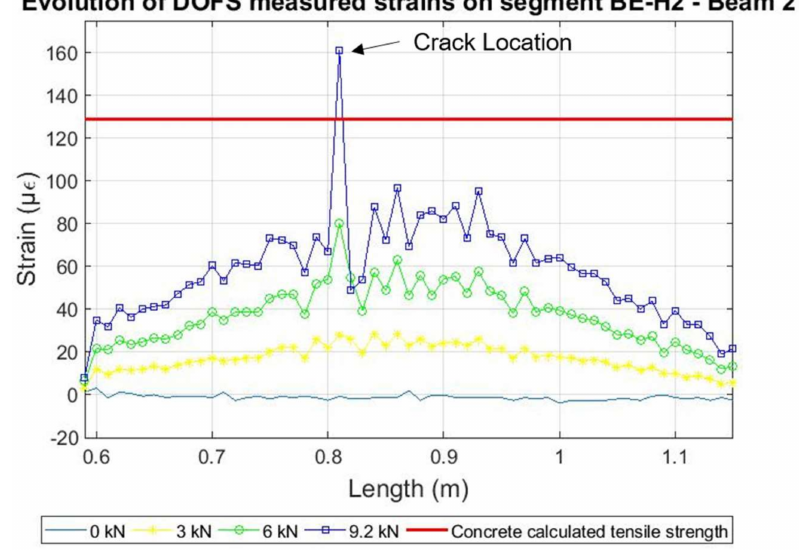
Figure 13. Detection of cracking at the surface of the concrete in beam